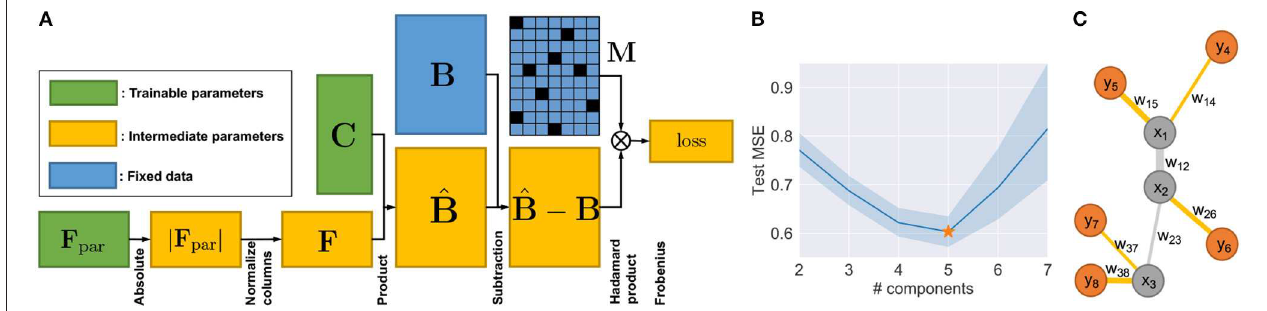
FIGURE 2 | Method details. (A) Neural network architecture of NND. (B) Test errors of NND using 20-fold CV. Errors in unit of mean square error (MSE). (C) Illustration of a phylogeny with five extant nodes and three Steiner